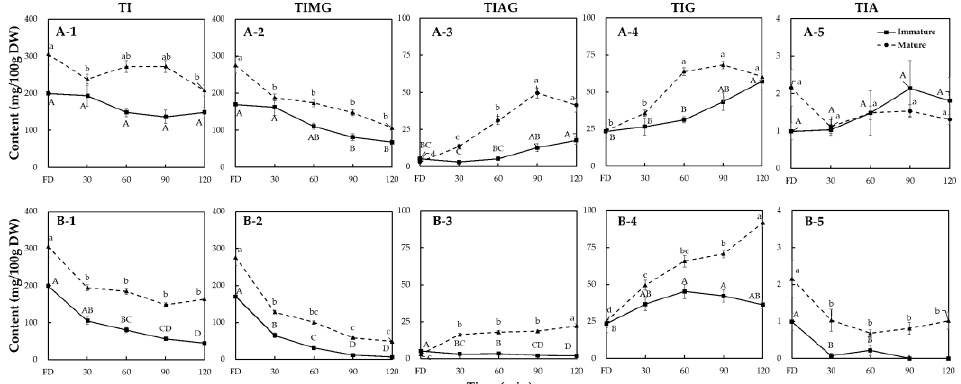
Figure 2. Changes in the total isoflavone (TI), total isoflavone malonylglycosides (TIMG), total isoflavone acetylglycosides (TIAG), total isoflavone β -glycosides (TIG), and total isoflavone aglycones (TIA) contents of immature and mature soybeans during dry-heating ( A ) and wet-heating ( B ). Data are shown as mean ± SE ( n = 3). Different letters indicate significant differences at p < 0.05 by Tukey’s studentized range (HSD) test.